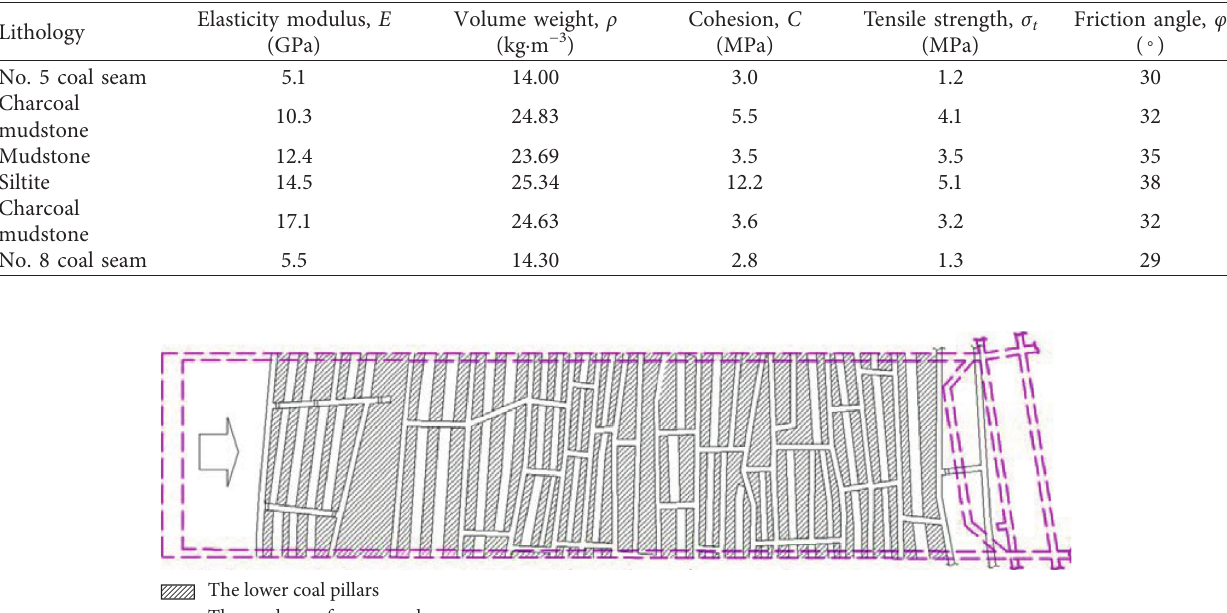
Table 2: Physical and mechanical parameters of lithology.